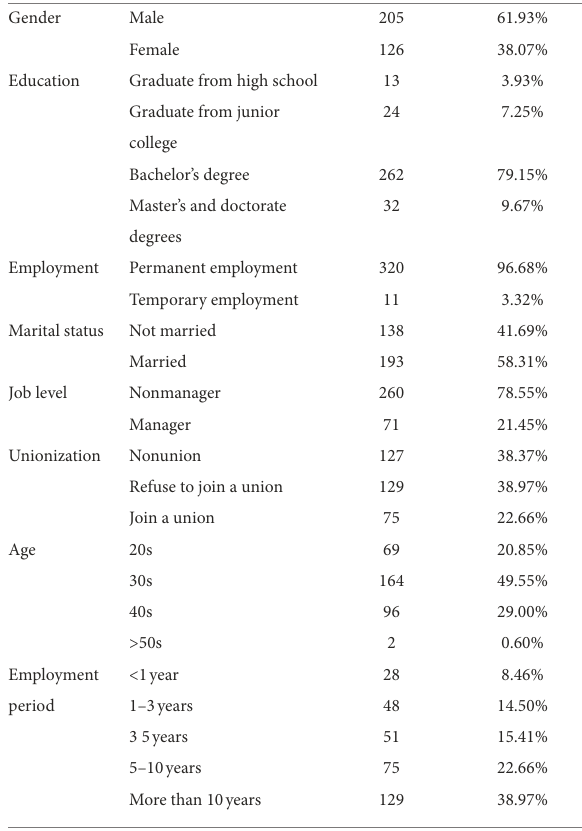
TABLE 2 Data sample characteristics of